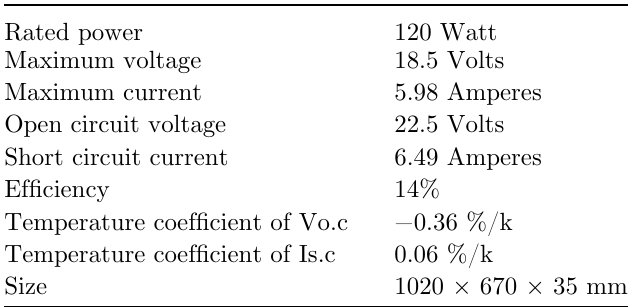
Table 1. Photovoltaic module speci fi